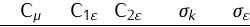
Table 1. Constants of the k- ε RNG model.